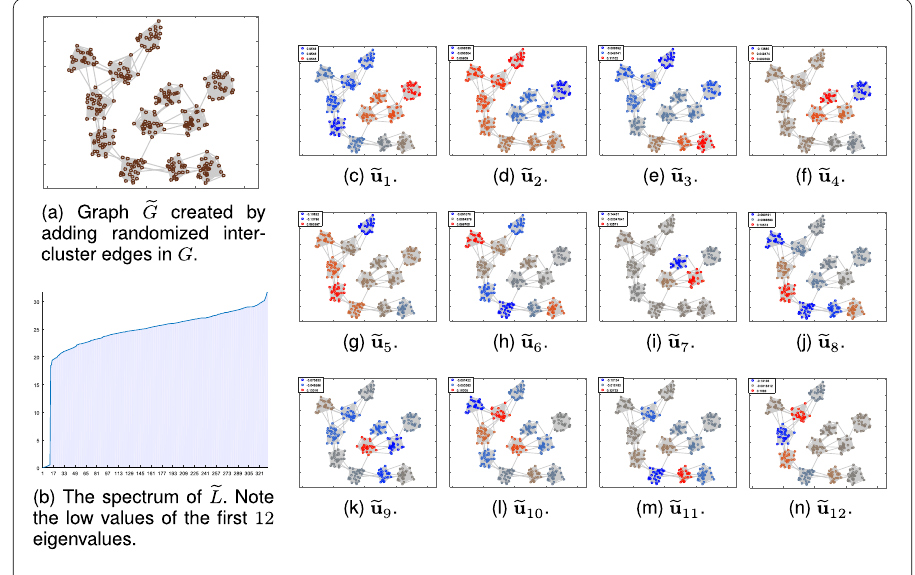
Figure 7 The graph (cid:2) G , the spectrum of its Laplacian, and its first 12 eigenvectors ( c – n ) visualized as distribution over the vertices (red is positive, blue is negative)